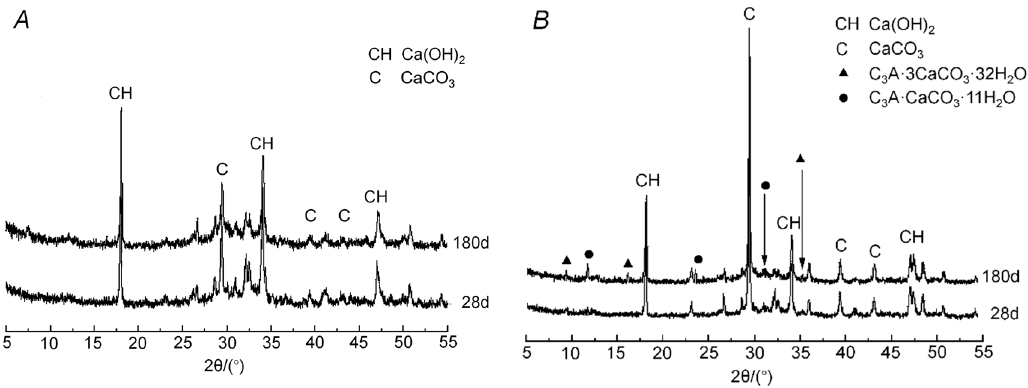
Figure 3. XRD analysis of OPC and cement matrix of LF-30. ( A ) OPC, ( B )